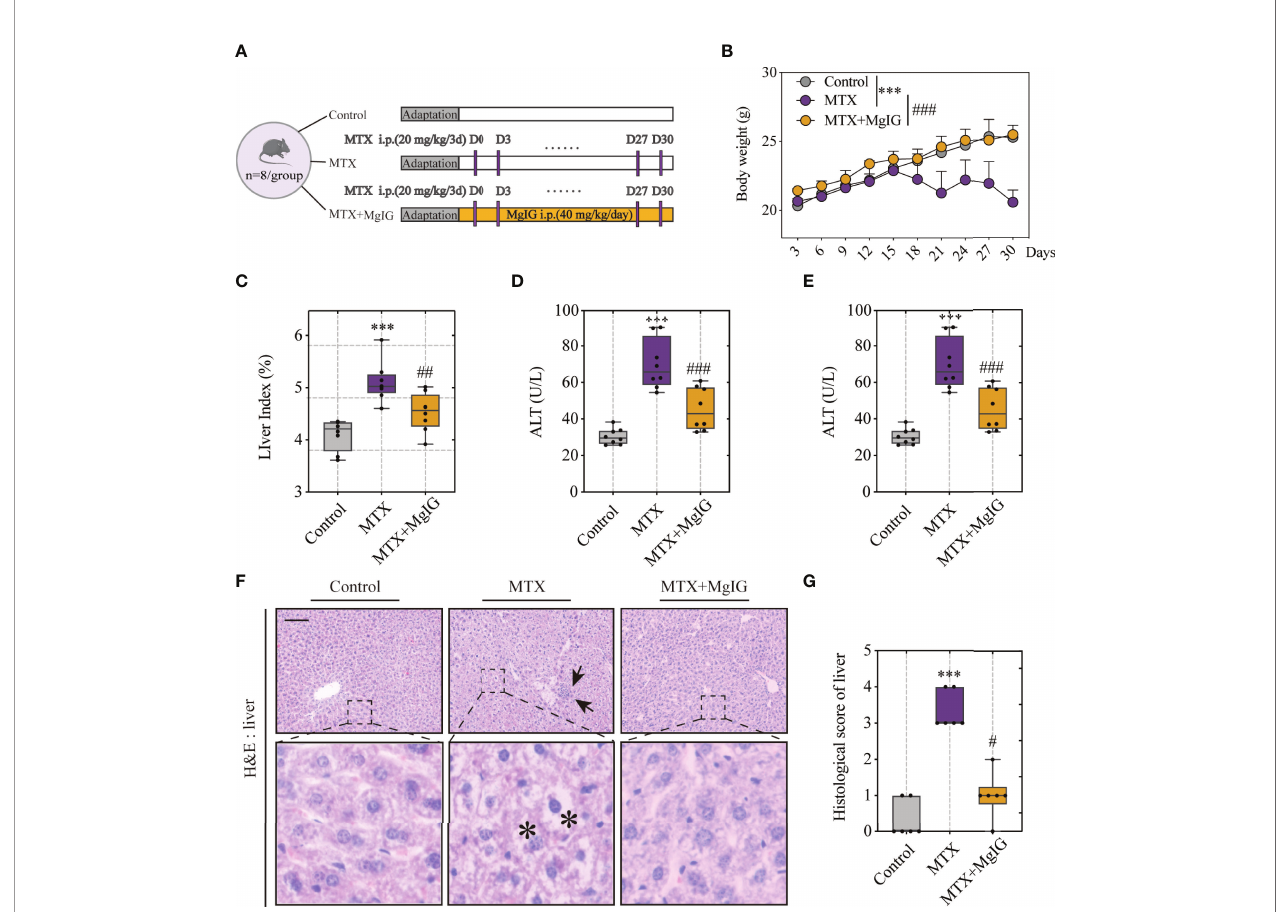
FIGURE 1 | MgIG alleviated MTX-induced liver injury. (A) Experiment design. (B) Bodyweights during mouse model development (n = 8, Two-way ANOVA). (C) Liver index (liver weight/body weight) of each group (n = 8). (D, E) ALT and AST levels in serum(n = 8). (F) Representative H&E staining images of liver tissue from each group. Arrows and asterisks in the sections indicate histopathological differences between groups: in fl ammatory in fi ltration (arrow) and necrosis (asterisk). Scale bar, 100 m m. (G) Histological score of liver tissue in each group (n = 6, Kruskal-Wallis test). ***p < 0.001, compared with Control group. # p < 0.05, ## p < 0.01, ### p < 0.001, compared with MTX